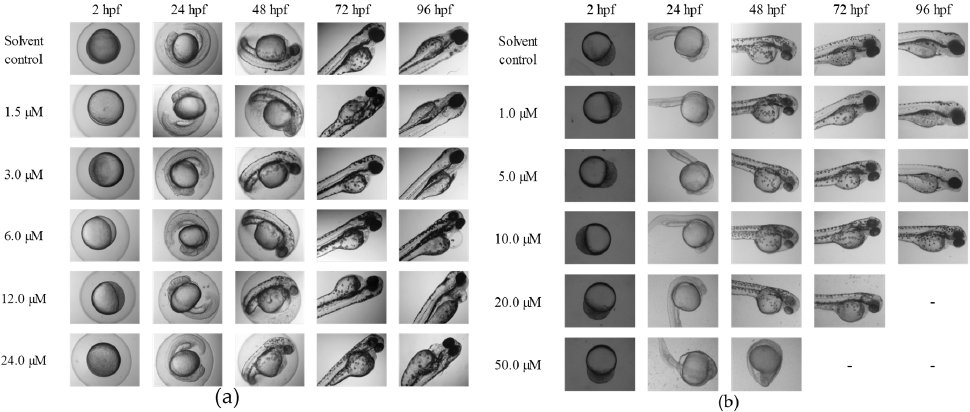
Figure 3. Morphology of zebrafish embryos exposed to Tan-IIA. ( a ) Morphology of chorionic embryos; ( b ) Morphology of dechorionated embryos—denotes that the treated embryos were all dead.